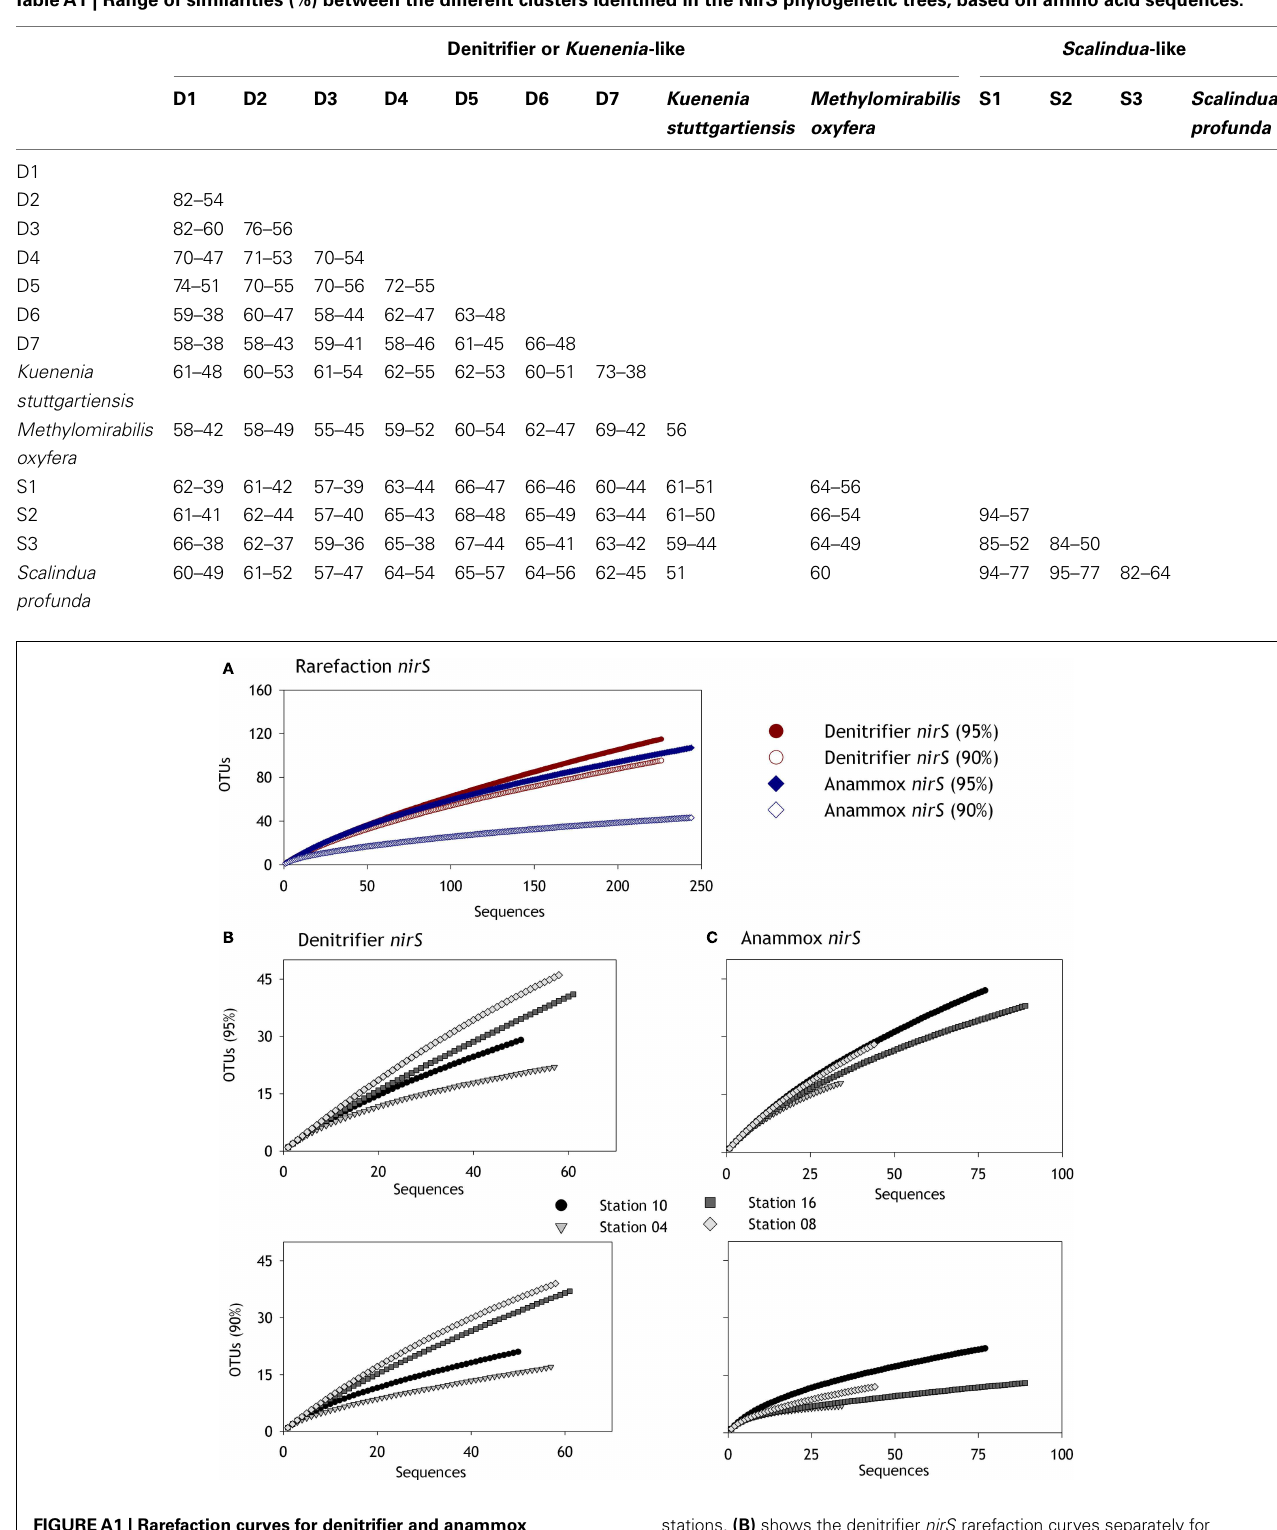
FIGUREA1 | Rarefaction curves for denitrifier and anammox (Scalindua) nirS sequences based on 95% and 90% nucleotide sequences cut offs. (A) Shows rarefaction curves over all sampled